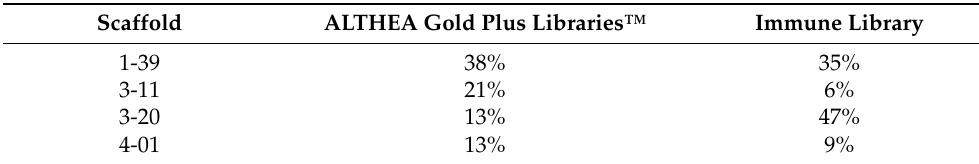
Table 4. VL scaffold